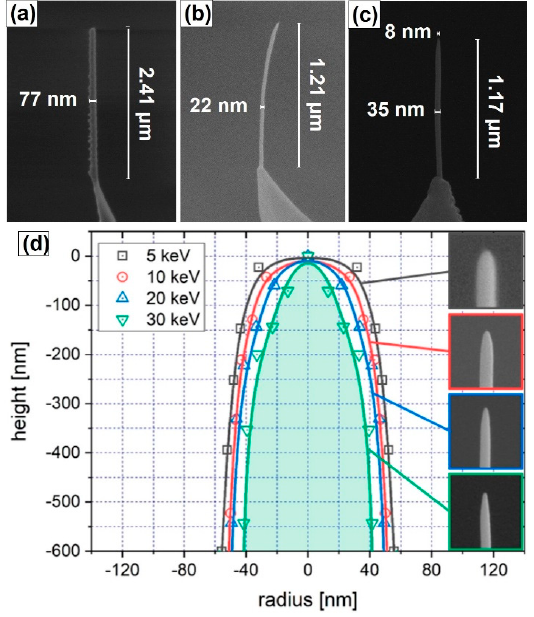
Figure 3. SEM images of ( a ) a core-shell Fe@Pt nanowire with a core diameter of 54 nm grown at 5 kV, ( b ) the thinnest 3D Fe nanowire ever achieved by us, grown at 30 kV, and ( c ) an Fe nanowire fabricated with an extremely sharp tip end with only ~8 nm in diameter grown at 30 kV, reproduced from [61]. ( d ) Study of the tip end morphology as a function of the voltage, adapted from [59].